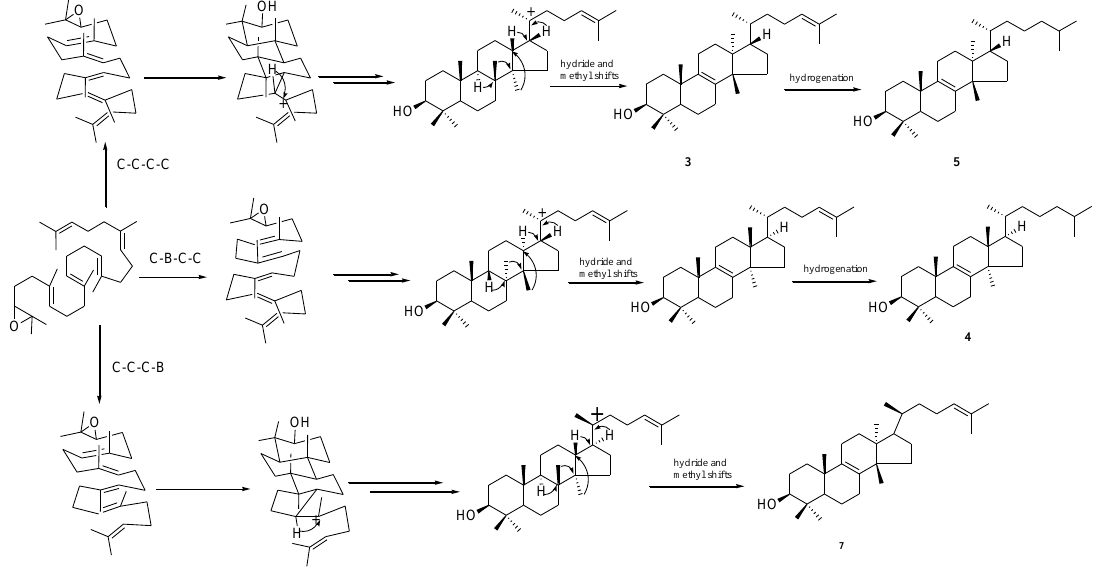
Figure 4. Oxidosqualene cyclases convert oxidosqualene to diverse cyclic structures.